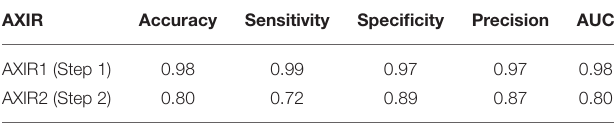
TABLE 6 | Classification performance of AXIR1 (Normal/Abnormal) and AXIR2 (TB/non-TB). AXIR Accuracy AUC AXIR1 (Step 1) 0.98 0.97 0.98 AXIR2 (Step 2) 0.80 0.72 0.89 0.87 0.80